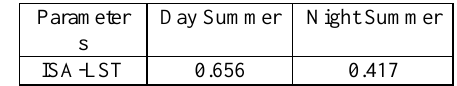
Table 4. Correlation coefficients between ISA and LST